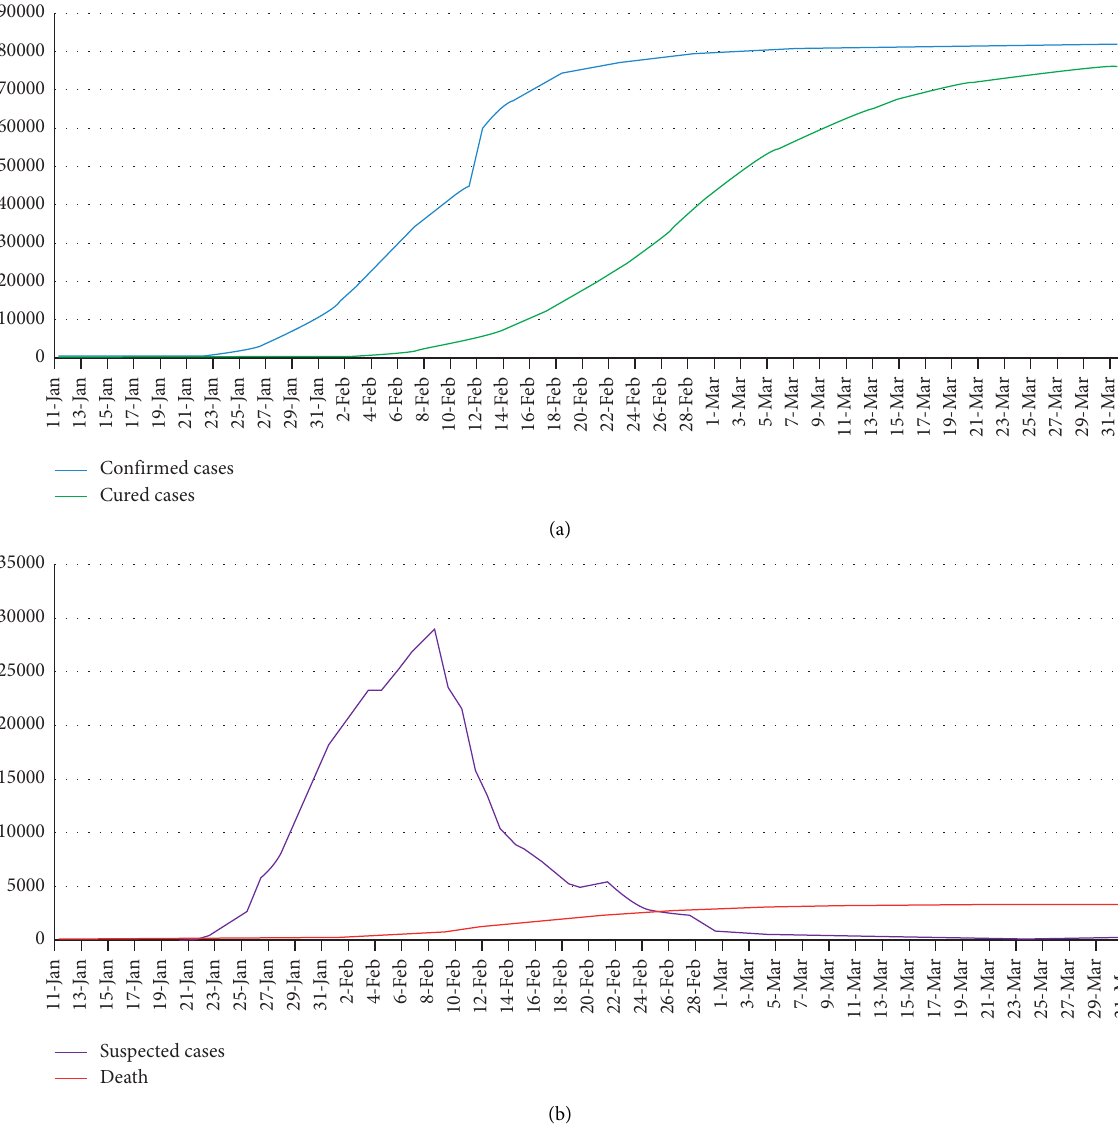
Figure 1: (a) Confirmed cases and cured cases and (b) suspected cases and deaths of novel coronavirus pneumonia (NCP) from January 11 to March 31, 2020, in mainland China. The data obtained from the official website of the National Health Commission of the People’s Republic of China